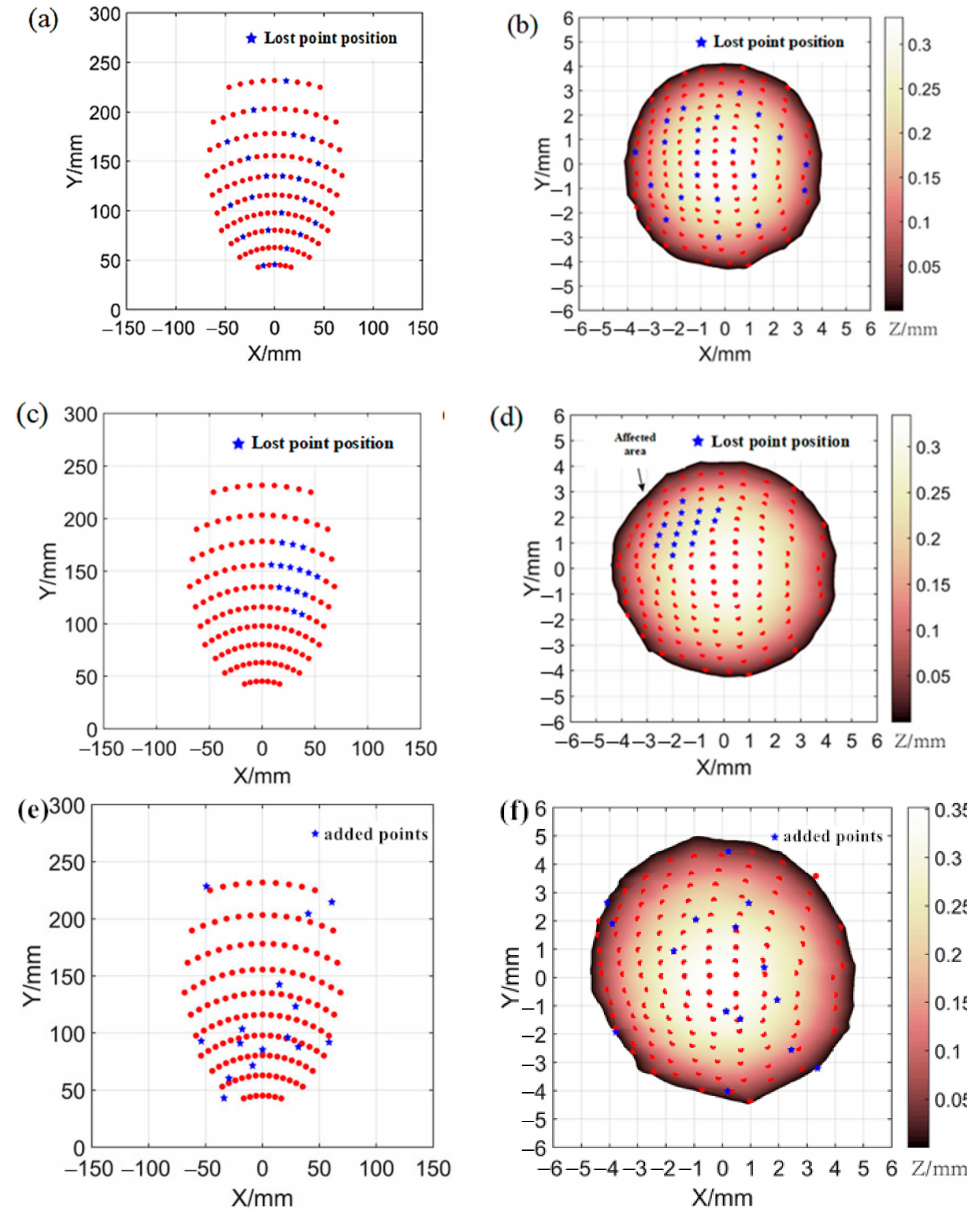
Figure 13. The samples with the phenomena of missing points and more points and their recon- structed surfaces. ( a ) The reflection image of scattered missing points (15% lost points, 12 points lost in total); ( b ) the reconstructed surface of Figure 13a; ( c ) the reflection image of concentrated missing points (15 points lost in focus); ( d ) the reconstructed surface of ( c ); ( e ) the reflection image of random adding points (add 15 points totally); ( f ) the reconstructed surface of ( e )